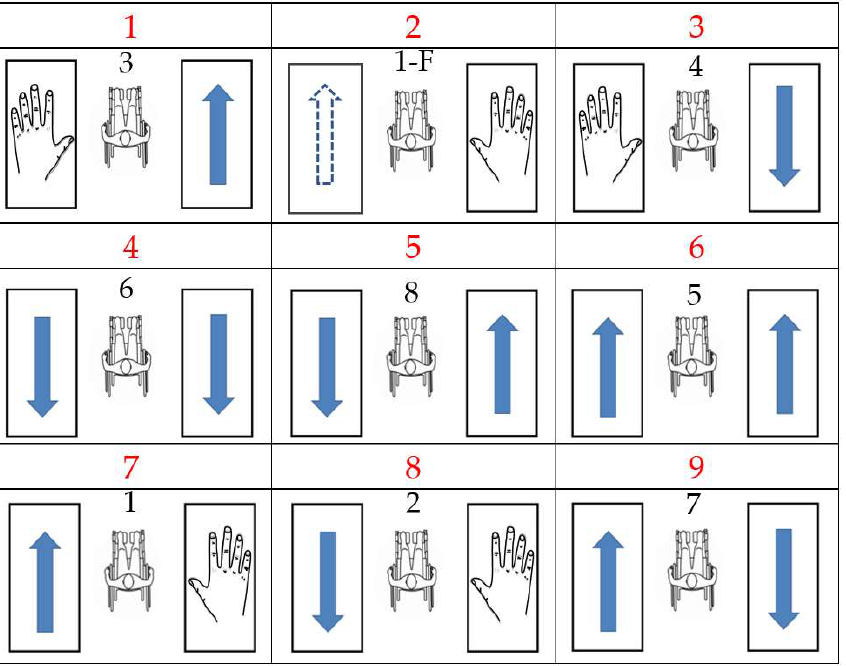
Figure 8. Example of MWD choreography for data acquisition. Propulsion images were presented to the subjects to show what propulsion gesture they must perform. The arrows indicate the arm that will propel and the sense, the hand draw indicates doing a dance movement when only one hand is propelling, and the dot-lined arrow indicates a fake propulsion gesture. Red numbers are the order of the gestures in the choreography.